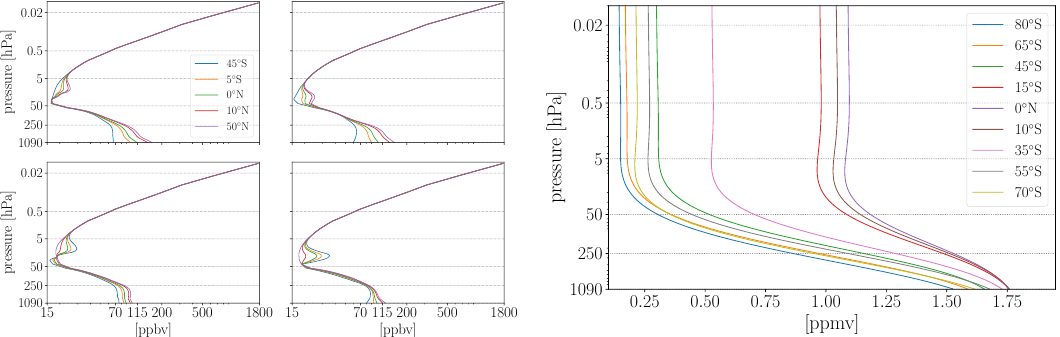
Figure 6. Initial guess mole fraction profiles for CO (four panels on the left) and CH 4 (right) resembling the Atmospheric Infrared Sounder (AIRS) version 6 first guess. The CO profiles are provided with monthly granularity for both hemispheres while only January, April, July and October (clockwise from top-left) are shown